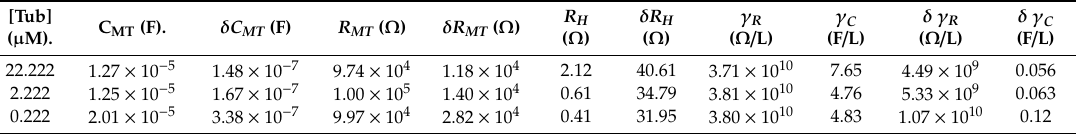
Figure 8. Mean di ff erences of ( a ) imaginary and ( b ) real impedance curves for 0.222 µ M, 2.222 µ M and 22.222 µ M, are fitted with the model described in Equation (6) and Figure 7. Fit parameters and confidence intervals are displayed in Table 2. The region between 1–100 Hz was not fit because of the negative di ff erences in resistance from background BRB80T solutions. Table 2. Fit parameters attained by fitting the real and imaginary components of impedance to Equation (7). Fit parameters represent e ff ective capacitance C MT , and resistance R MT introduced into the solution through the addition of the MT network at di ff erent concentrations. R H is the small constant resistance that is ascribed to small fraction of unpolymerised tubulin that is present in MT-containing solutions. γ R and γ C describe the e ff ective resistance and capacitance per unit volume introduced by the microtubule network. δ R MT , δ C MT and δ R H correspond to 95% confidence intervals for the fit parameters. The values δ γ R and δ γ C correspond to the uncertainties in the resistance and capacitance per unit volume. Corresponding graphs are displayed in Figure